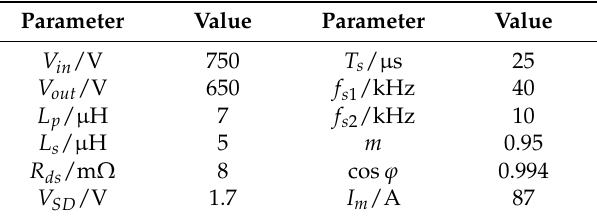
Table 2. The parameters of theoretical calculation.